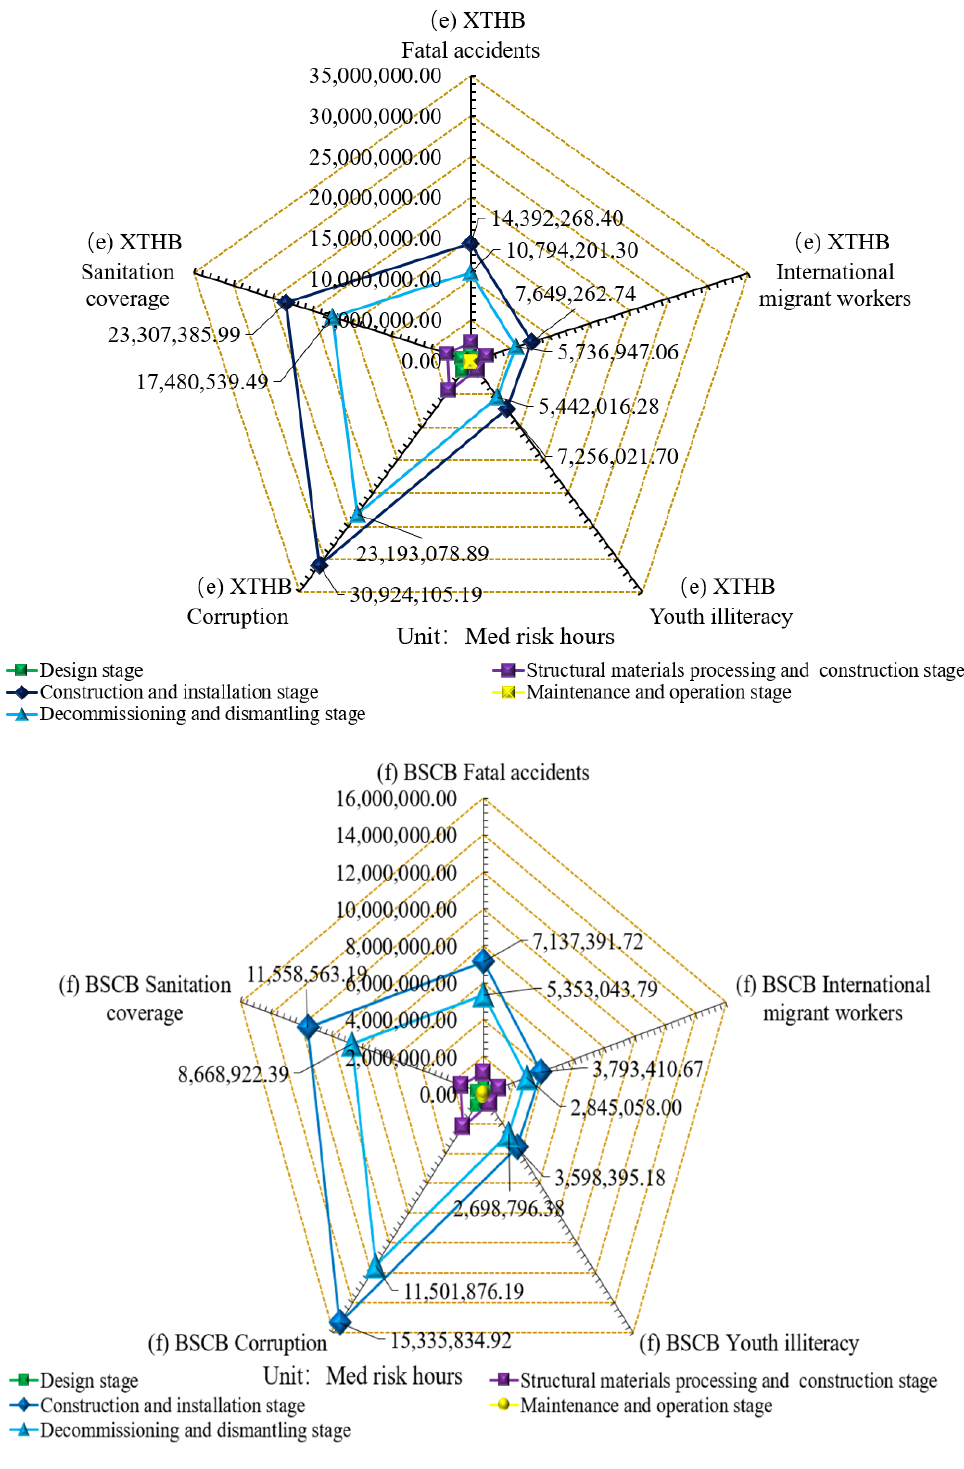
Figure 8. ( a ) The content in the first panel is the description of the five SILA factors of STHB; ( b ) The content in the second panel is the description of the five SILA factors of SZBB; ( c ) The content in the third panel is the description of the five SILA factors of BGNB; ( d ) The content in the fourth panel is the description of the five SILA factors of CJWB; ( e ) The content in the fifth panel is the description of the five SILA factors of XTHB; ( f ) The content in the sixth panel is the description of the five SILA factors of BSCB.